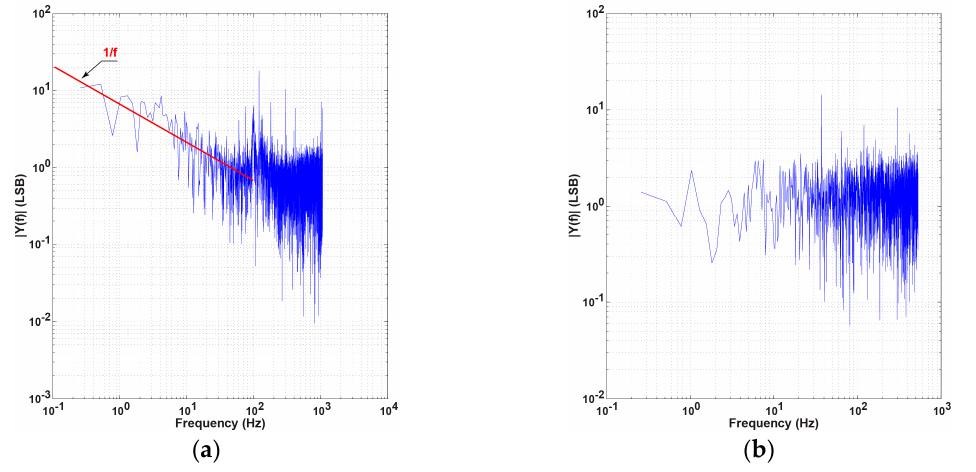
Figure 18. 1/f noise reduction effect of the double modulation: ( a ) without double modulation technique ( b ) with double modulation technique.